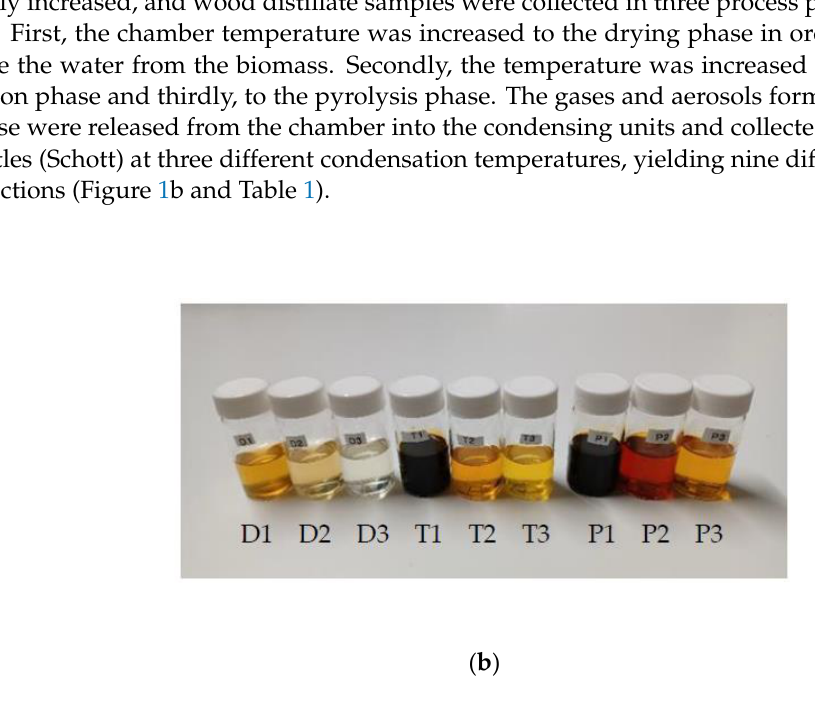
Figure 1. ( a ) Pine sawdust raw material samples in metal holders before pyrolysis process. ( b ) Representative distillate fractions from drying (D1, D2, D3), torrefaction (T1, T2, T3) and pyrolysis (P1, P2, P3) phases after pyrolysis process.